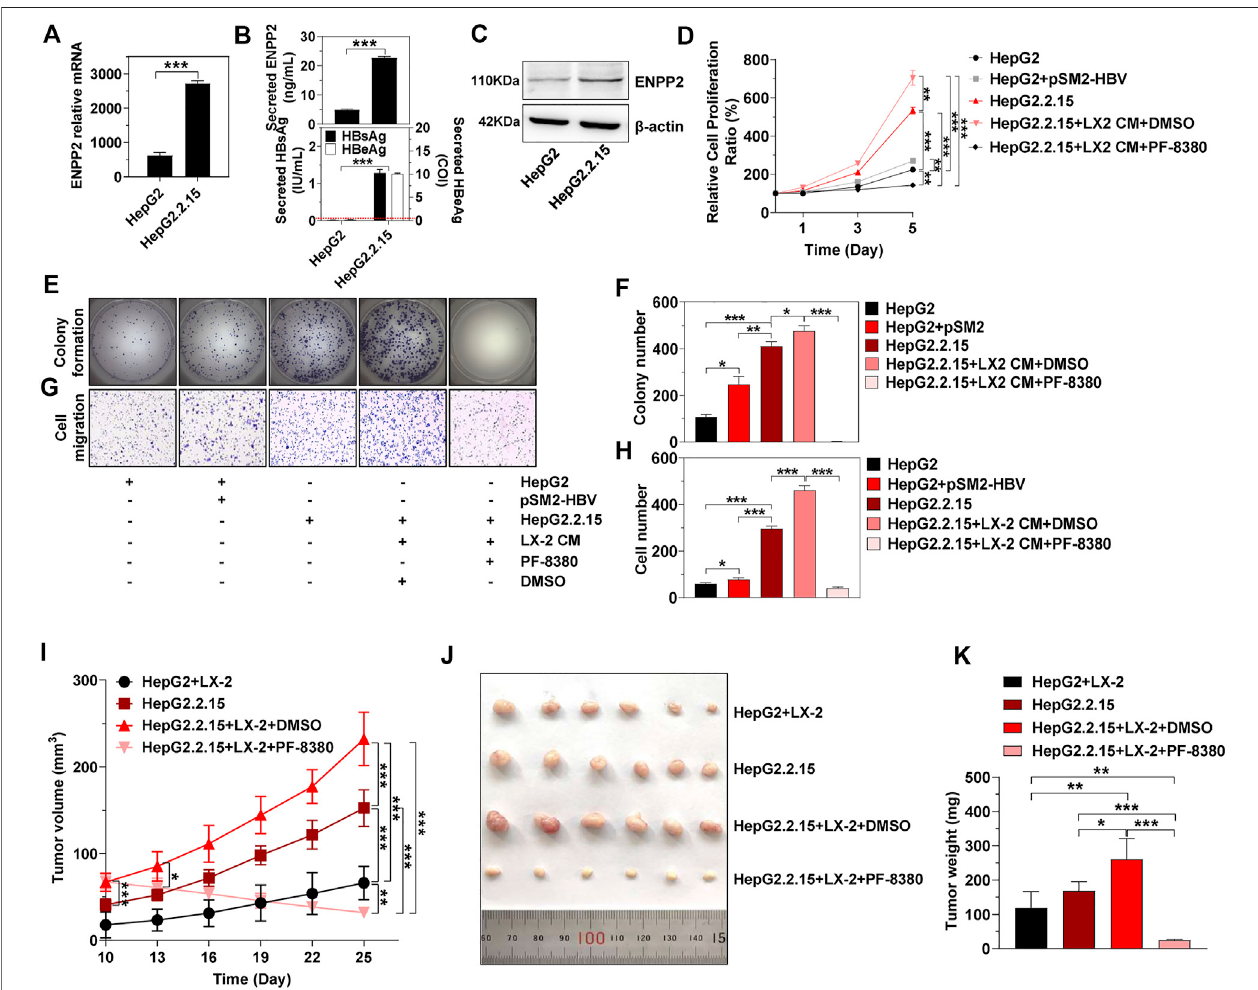
FIGURE 6 | HBV and aHSC induce HCC progression synergistically in vivo . (A) The level of enpp2 mRNA in HepG2 and HepG2.2.15. (B) The secretory ENPP2, HBsAg,andHBeAginsupernatantsfromHepG2andHepG2.2.15.ThereddottedlineinthegraphrepresentedthecutoffforHBsAgandHBeAg.Thestatisticalanalysis was based on three independent experiments. (C) The intracellular ENPP2 protein in HepG2 and HepG2.2.15. HepG2.2.15 and HepG2, transfected with vector or pSM2-HBV for1 day (setasday 0), were treatedwithLX-2 CM containingDMSO or PF-8380, and then hepatoma cellfunctionwasdetected. (D) Cell proliferation for each group. The statistical analysis was based on three replicates. (E) Representative images of colony formation for each group cells. ( F ) The bar graph of colony number indicated quantitative analysis data based on three independent experiments for each group of cells. (G) Representative images of the cell migration assay for each group of cells (magni fi cation × 100). (H) The bar graph of cell number migrated from Transwell indicated quantitative analysis data based on three independent experiments for each group of cells. (I) Tumor growth at different times in each group in nude mice (error bars, SD of six mice per group). (J) The fi nal tumor size in nude miceupon subcutaneoustransplantation with hepatoma cells or co-transplantation withhepatoma cells withLX-2 (3:1 ratio). Indicated groups weretreatedwith vehicle DMSO or PF-8380 for two consecutive weeks. (K) Bar charts show the fi nal tumor weight of each group of mice. *, p < 0.05; **, p < 0.01; ***, p <